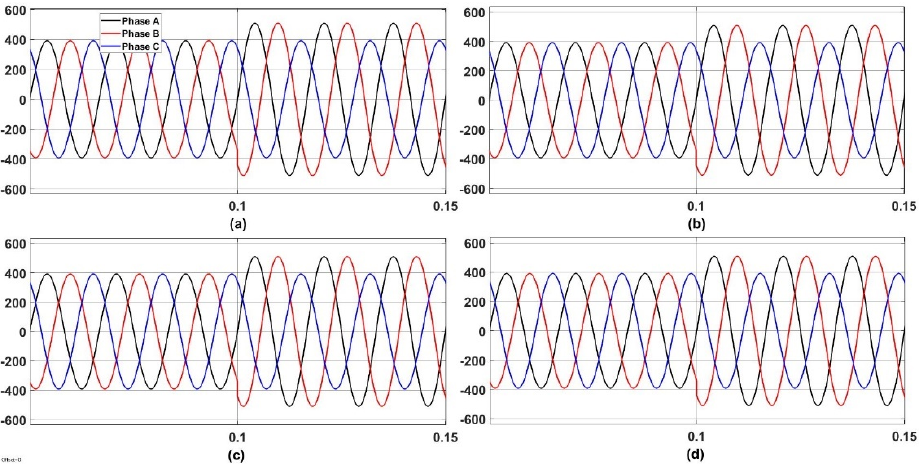
Figure 25. Three-phase pcc voltages in an unbalanced swell in the case of ( a ) 2L- αβ , ( b ) 3L- αβ , ( c ) 2L-dq and ( d ) 3L-dq .